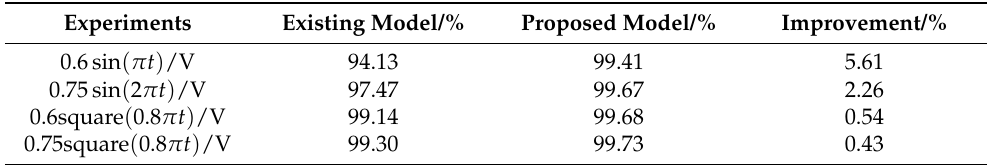
Table 3. The Pearson correlation coefficient for open-loop time responses.